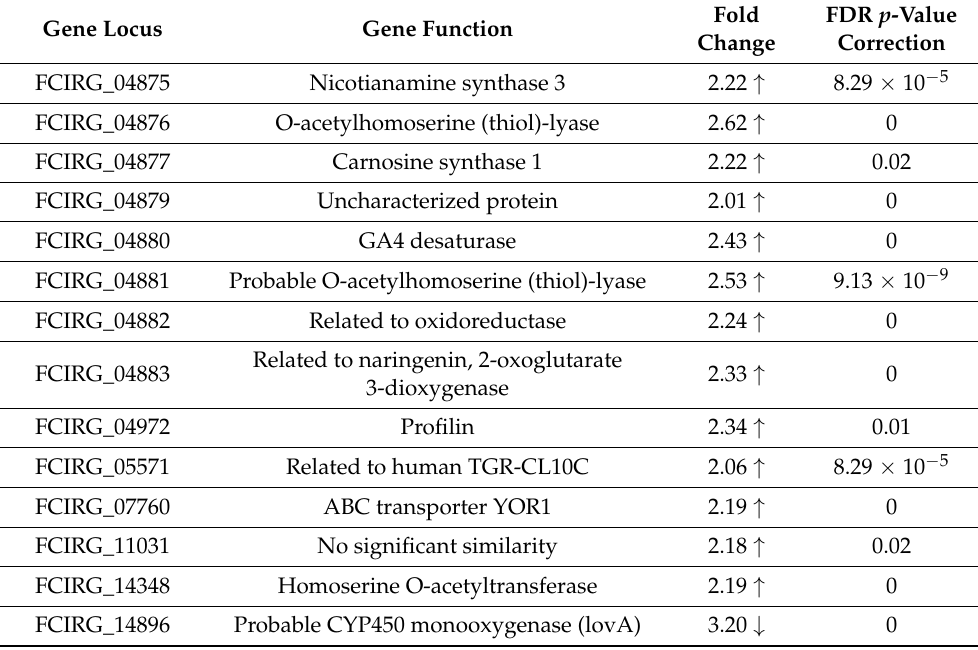
Table 5. GO terms of the differentially expressed genes. ↑ = upregulated by the FcMV1 residual effect; ↓ = downregulated by the FcMV1 residual